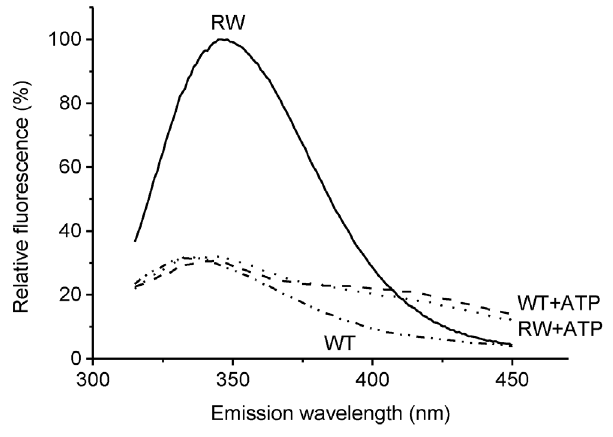
Figure 1. Emission spectra of a 3 b 3 c WT and a 3 b 3 c RW complexes of BF 1 . Fluorescence emission spectra of a 3 b 3 c WT and a 3 b 3 c RW complexes in the absence and presence of 1 mM ATP are shown. Excitation wavelength was 300 nm and the fluorescence emission spectra were recorded at 50 nm/min. Excitation and emission slit-widths were set at 5 and 10 nm, respectively. The fluorescence values are normalized to peak of a 3 b 3 c RW in the absence of ATP as 100%. Solid line, dotted line, two-dot-chain line and dashed line represent a 3 b 3 c RW -ATP, a 3 b 3 c RW + ATP, a 3 b 3 c WT -ATP and a 3 b 3 c WT + ATP, respectively.